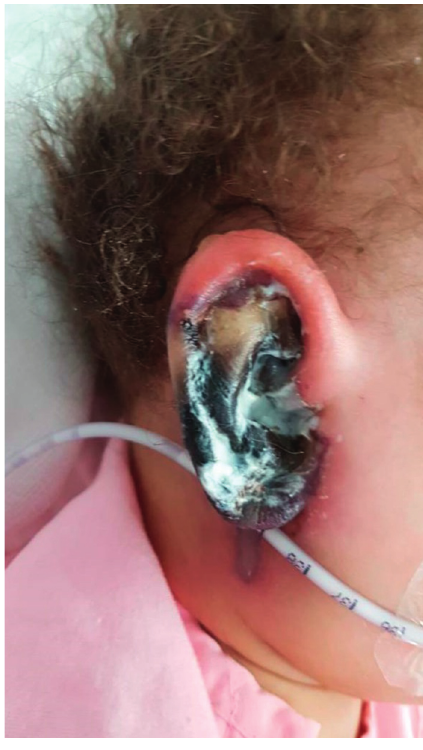
Figure 1: The patient’s ear upon